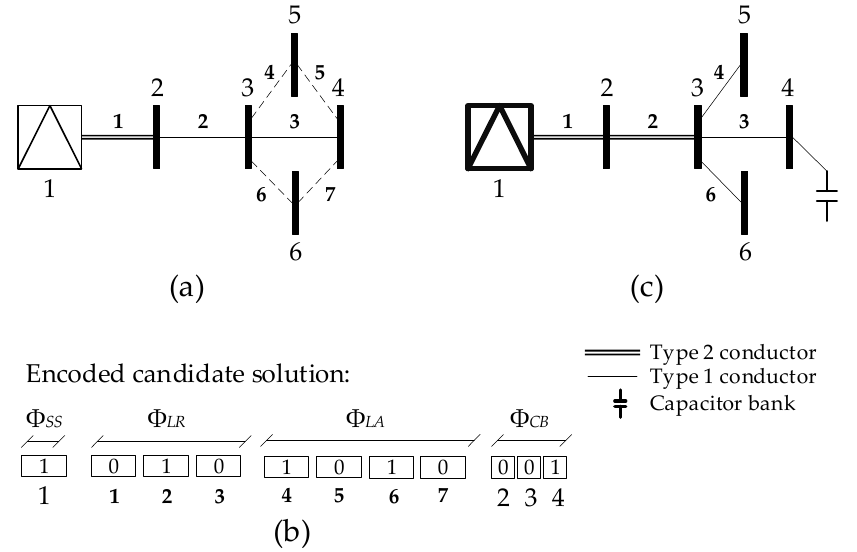
Figure 4. ( a ) Illustrative 6-bus distribution network, ( b ) Encoded candidate solution, ( c ) Decoded candidate solution.